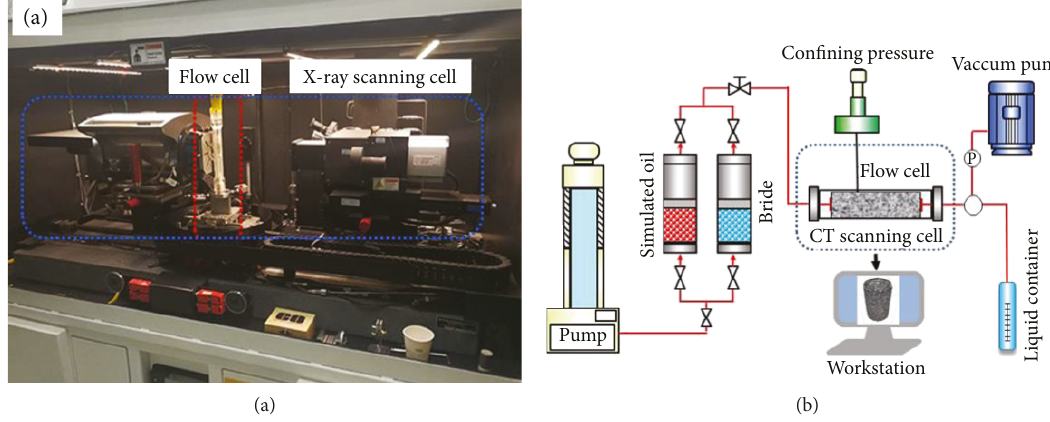
Figure 2: (a) The image of a micro fl ow equipment monitored by micro X-ray computerized tomography. (b) The schematic illustration of the micro fl ow equipment. Note: the pumps and valve arrangement is used to control fl uid fl ow to the fl ow cell within the CT enclosure.